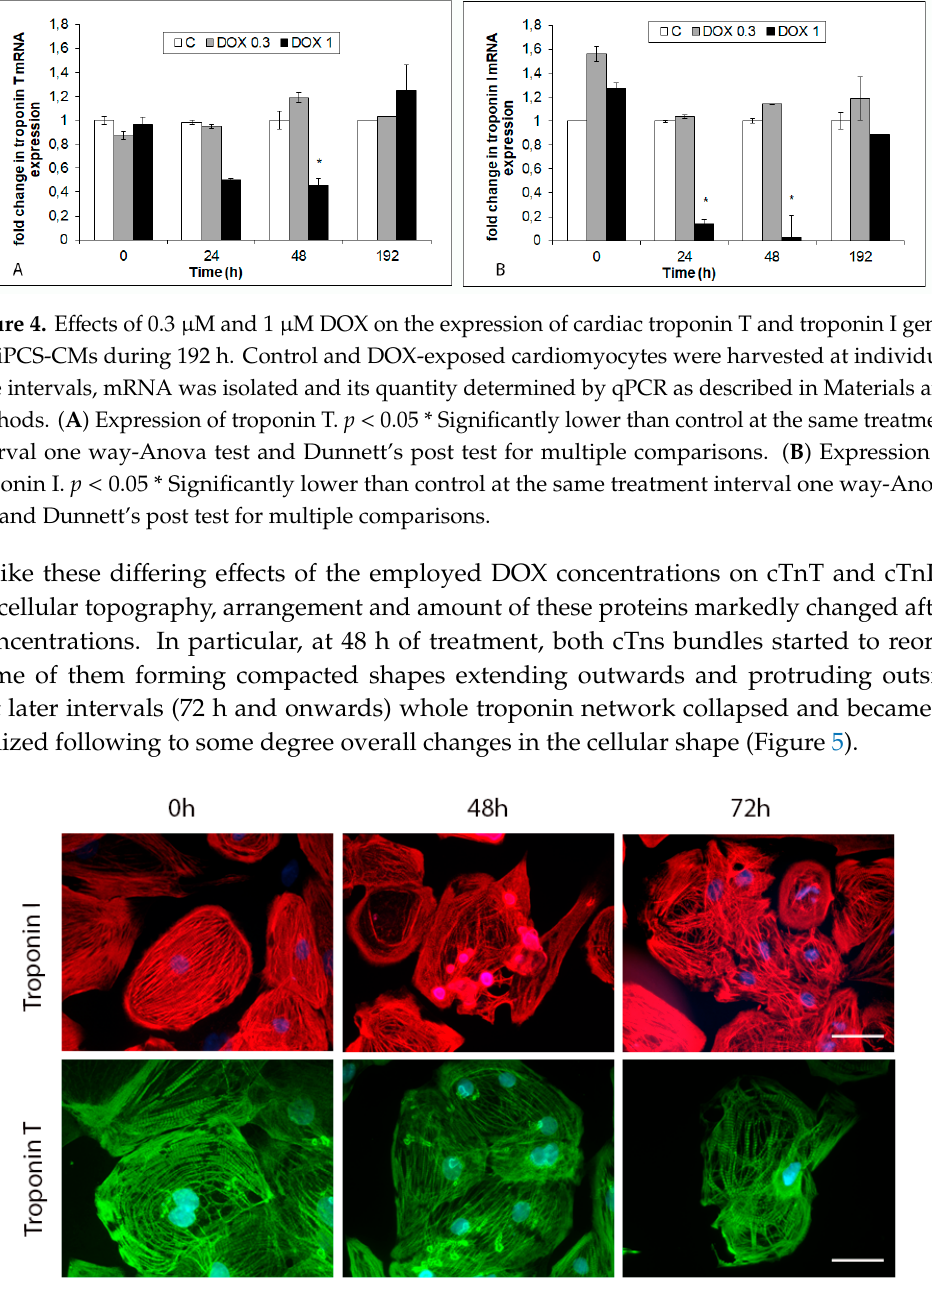
were examined by the fluorescent microscopy and cell analysis as described in Materials and